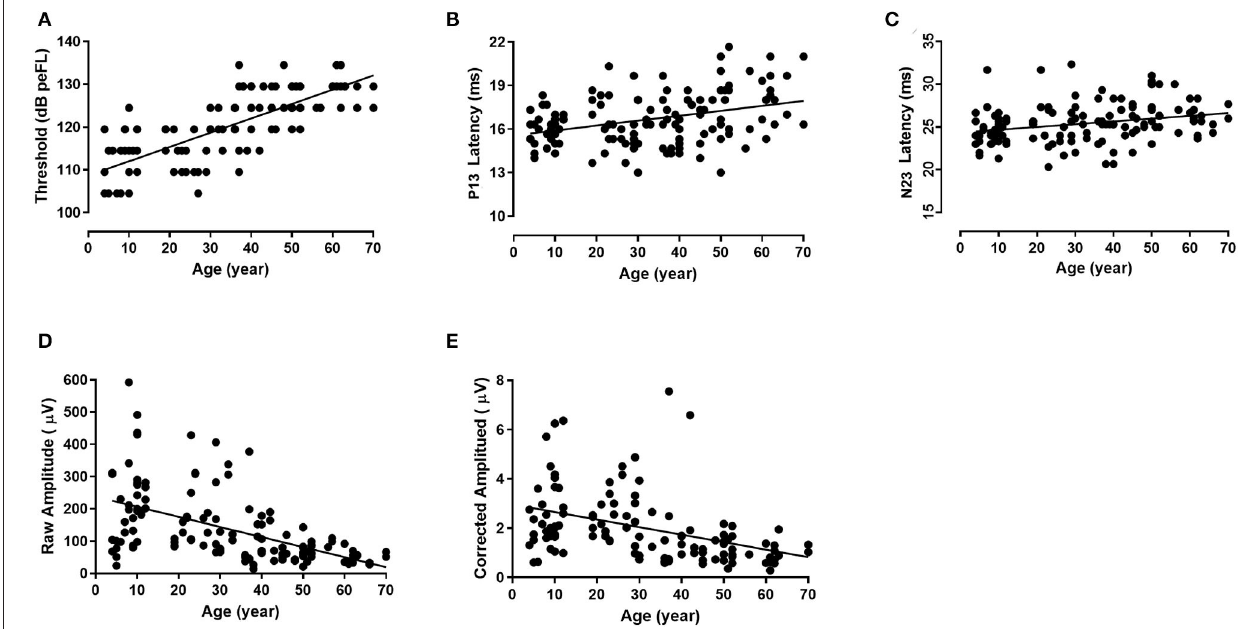
FIGURE 3 | The relationship between age and individual B81-cVEMP parameters (linear regression). The threshold (r 2 = 0.571, p = 0.000, p < 0.01) (A) , P13 latency (r 2 = 0.143, p = 0.001, p < 0.01) (B) , and N23 latency (r 2 = 0.096, p = 0.010, p < 0.05) (C) are positively correlated with age, whereas the raw amplitude (r 2 = 0.288, p = 0.000, p < 0.01) (D) and corrected amplitude (r 2 = 0.246, p = 0.000, p < 0.01) (E) are negatively correlated with age.